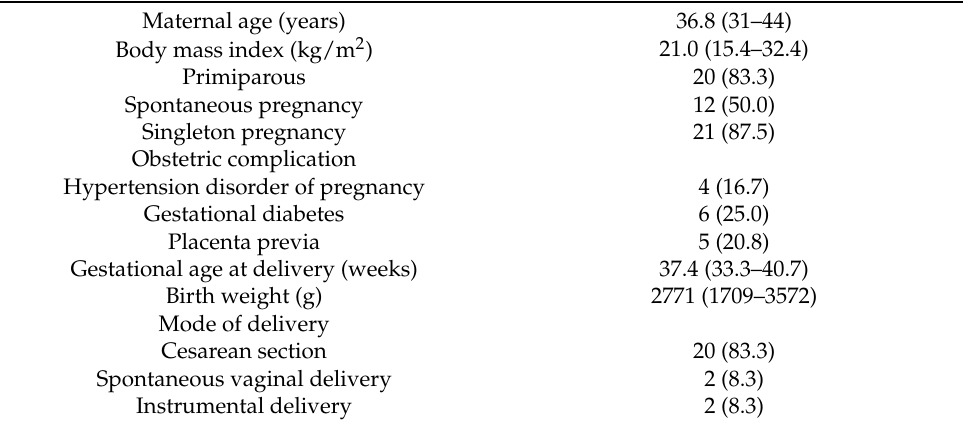
Table 1. Patient characteristics and obstetric outcomes.